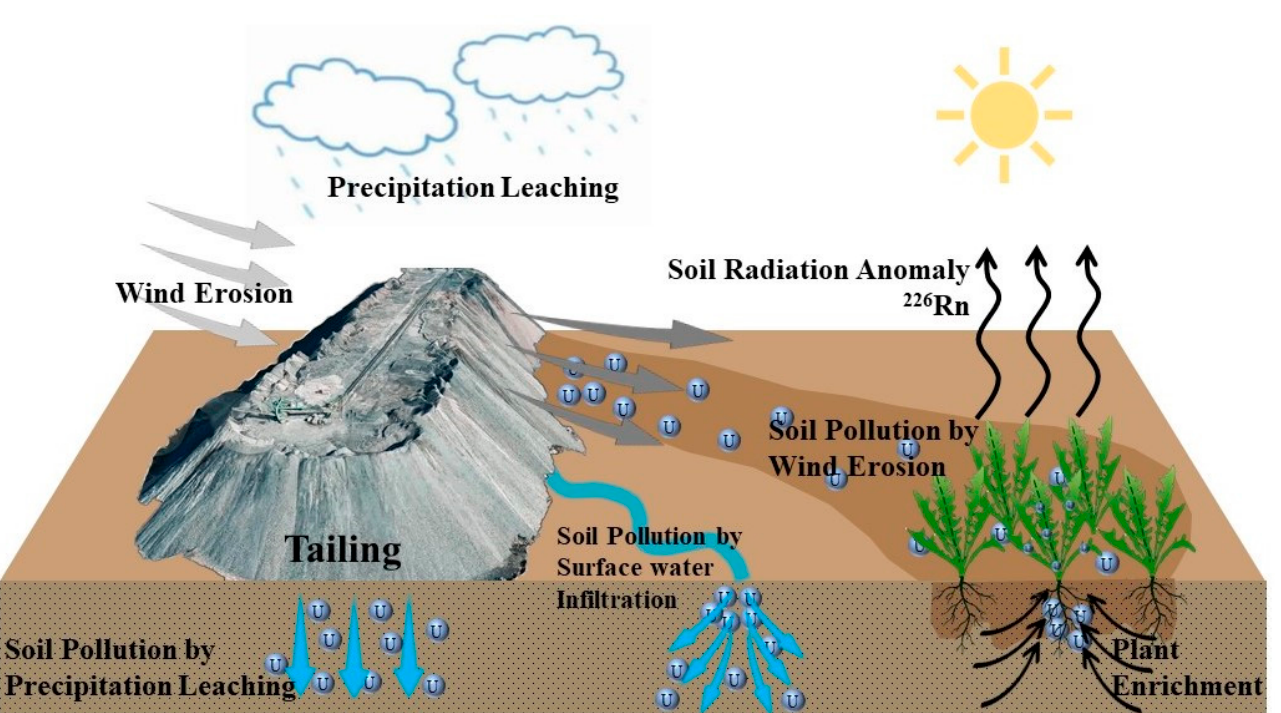
Figure 6. Soil pollution under wind erosion and precipitation leaching.